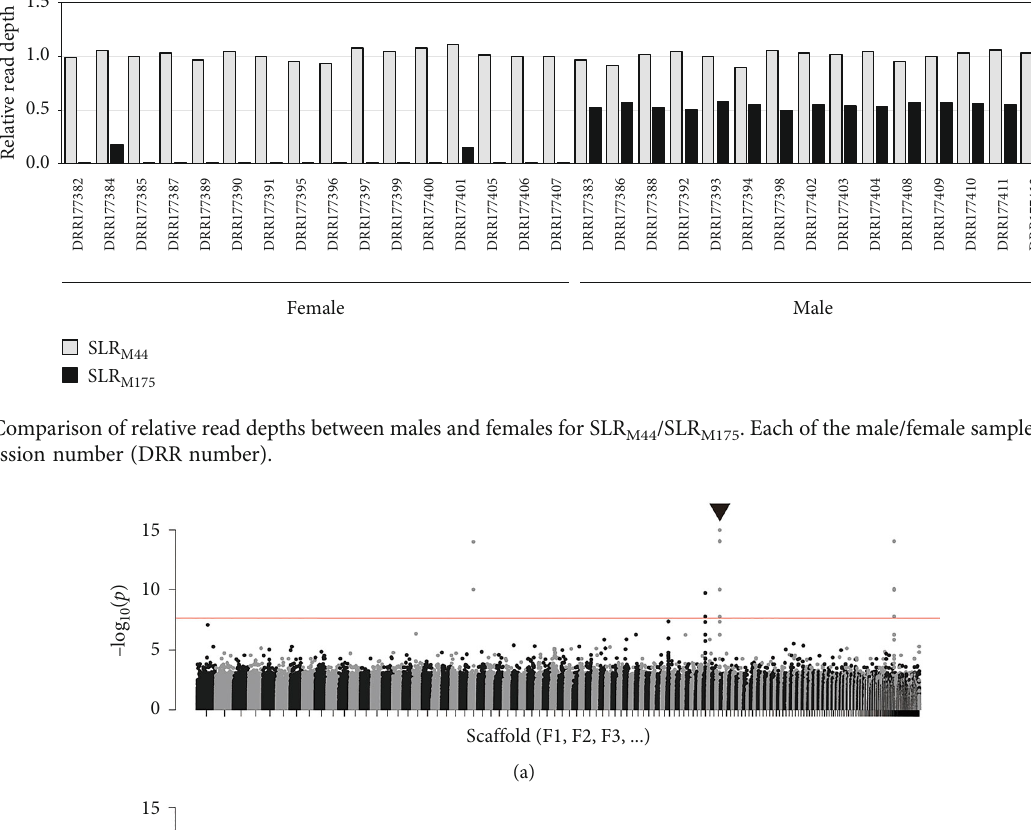
/SLR . Each of the male/female samples is indicated M44 M175